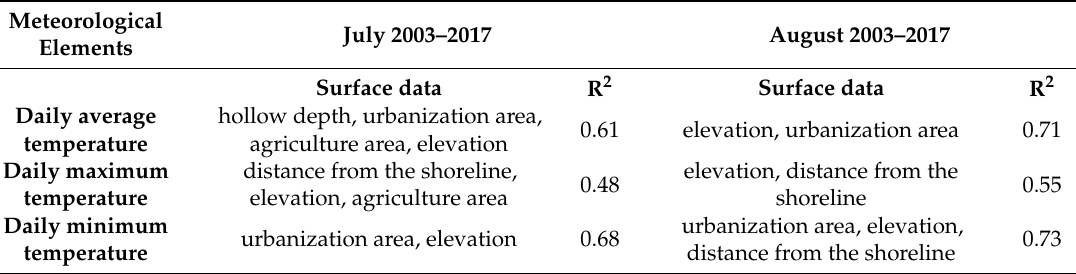
Table 5. Correlations among meteorological elements and surface